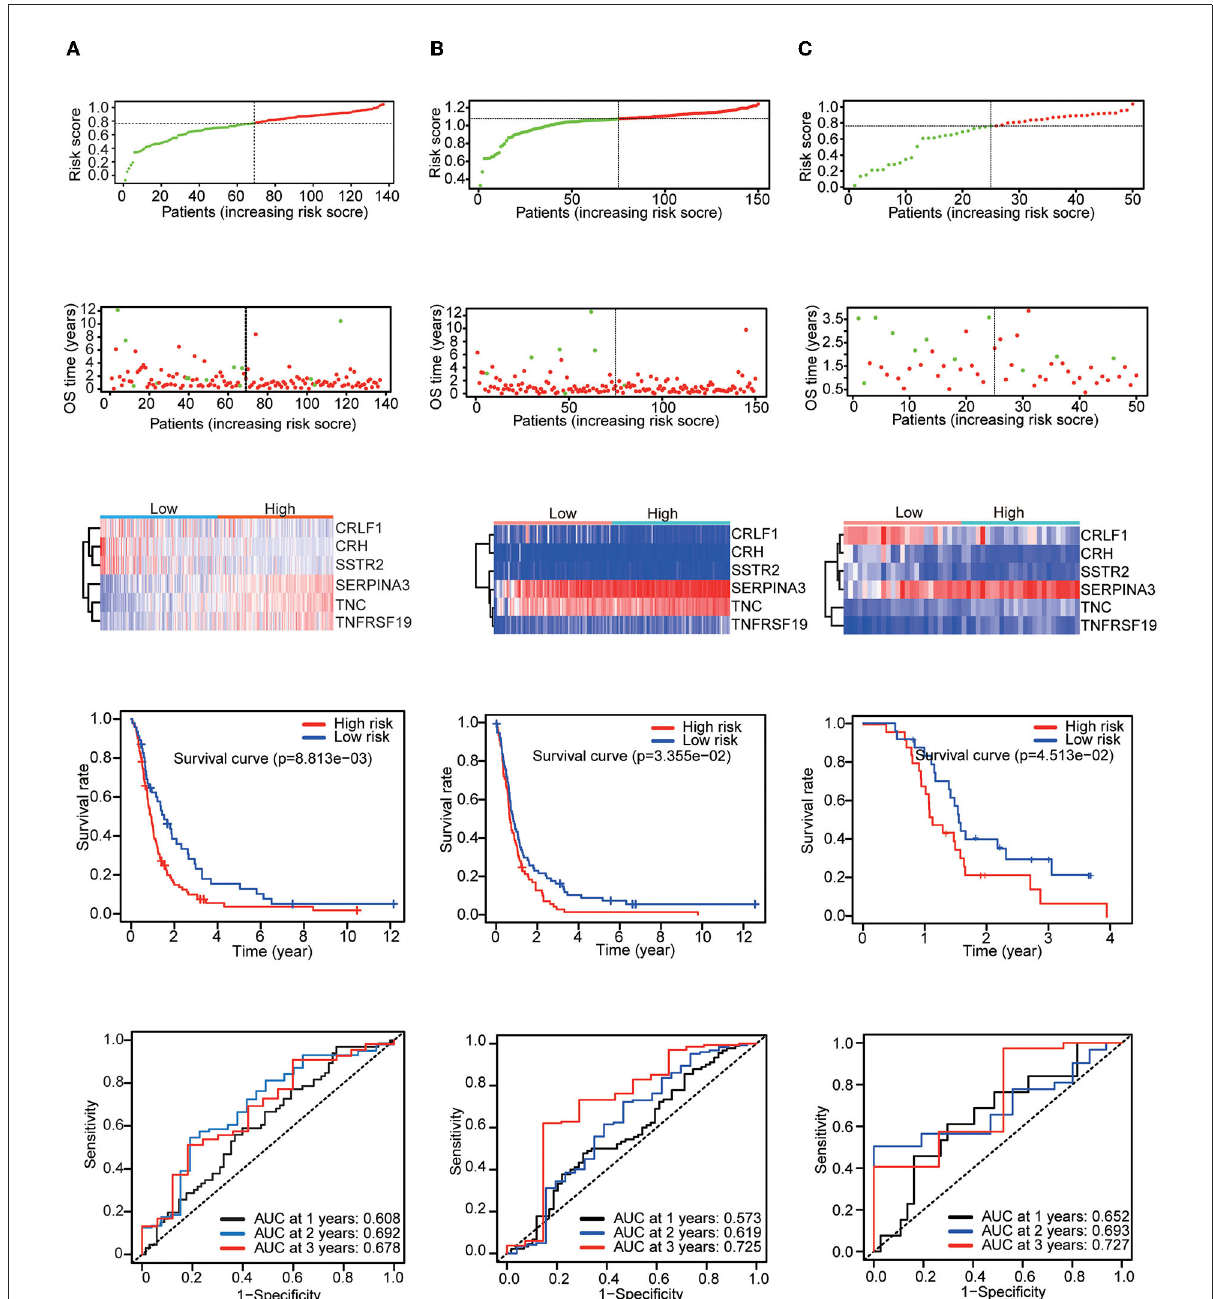
FIGURE4 Patients in the validation set were used to verify the risk score model. Top: The dotted line designates the median risk score and stratifies the patients into low-risk GBM and high-risk GBM groups. Middle: Survival status of the patients. Heatmap of the prognostic genes in the low-risk GBM and high-risk GBM groups. Bottom: Kaplan–Meier survival curves and time-dependent ROC curves of the patients in the validation sets. (A) CGGA mRNAseq_325 dataset. (B) GSE16011 dataset. (C) GSE83300